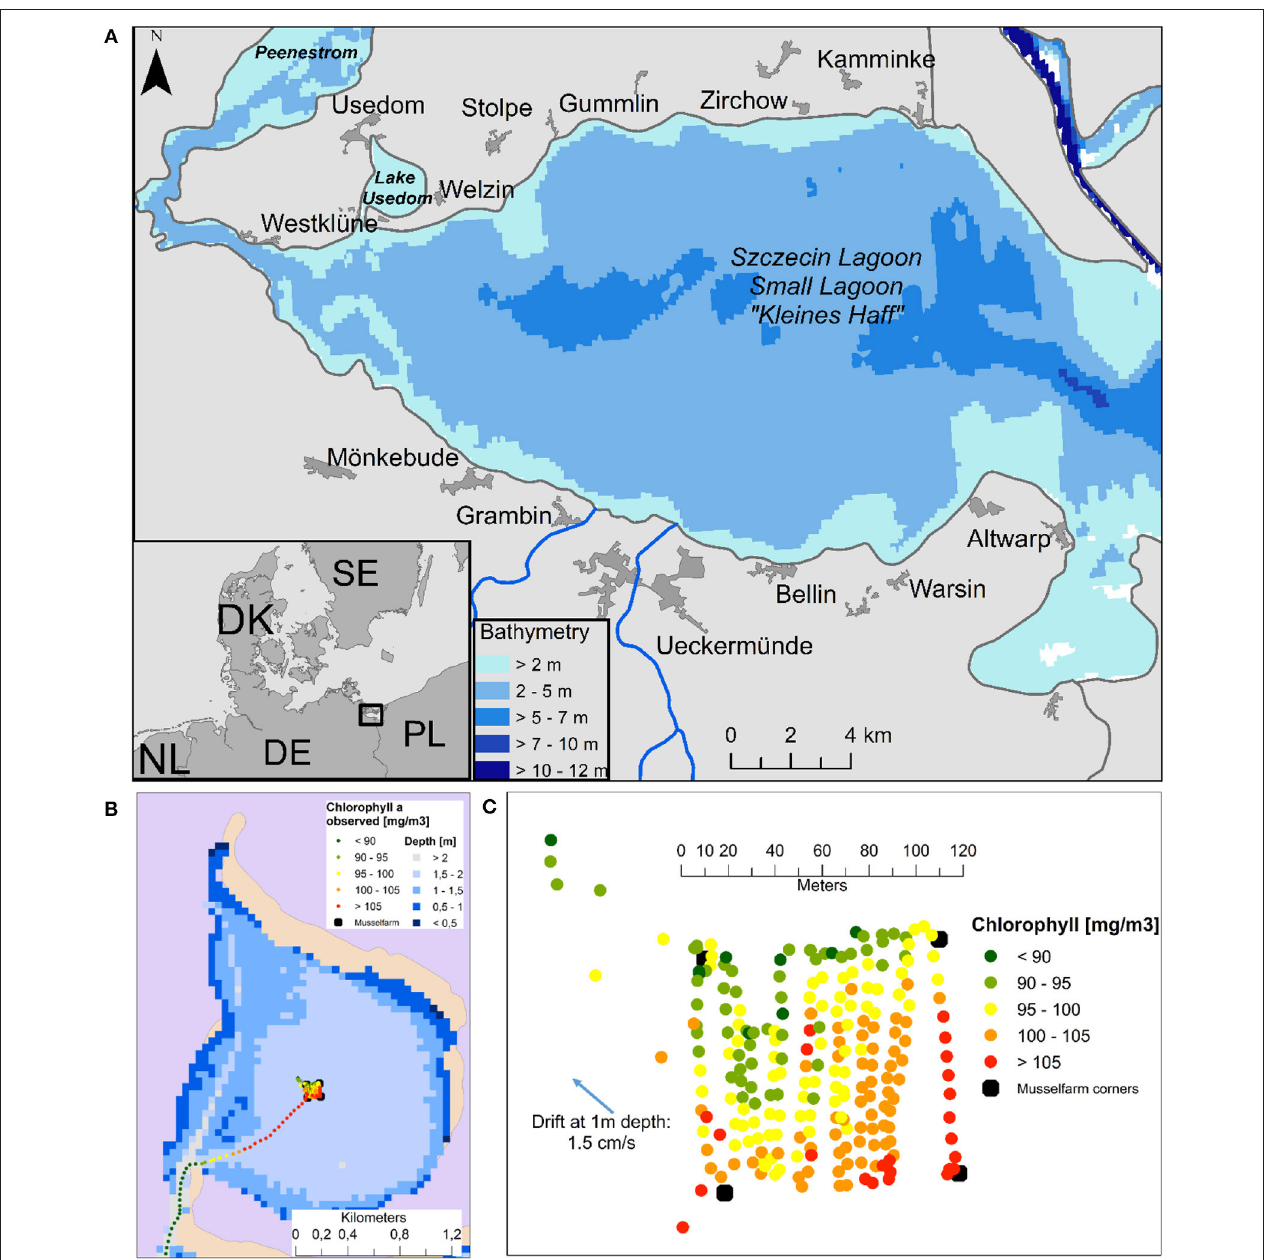
FIGURE 2 | (A) The German part of Szczecin Lagoon (B) surface Chlorophyll a concentrations [mg m − 3 ] from 25.9.2013 in Lake Usedom and (C) zoomed into the pilot farm.